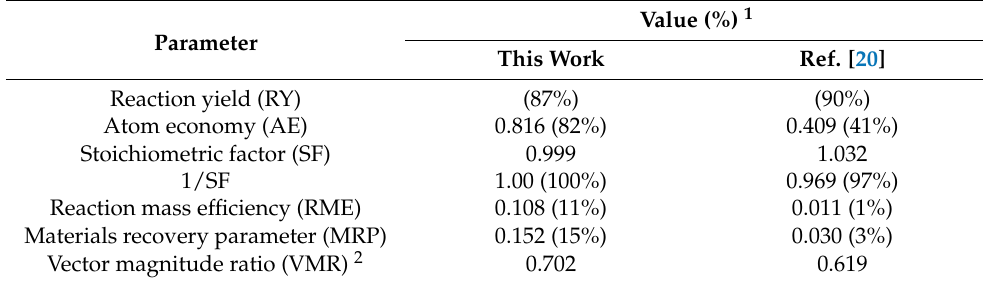
Table 2. Green metrics for the synthesis of 1,3-bis(3-carboxypropyl)imidazole ( bcpim